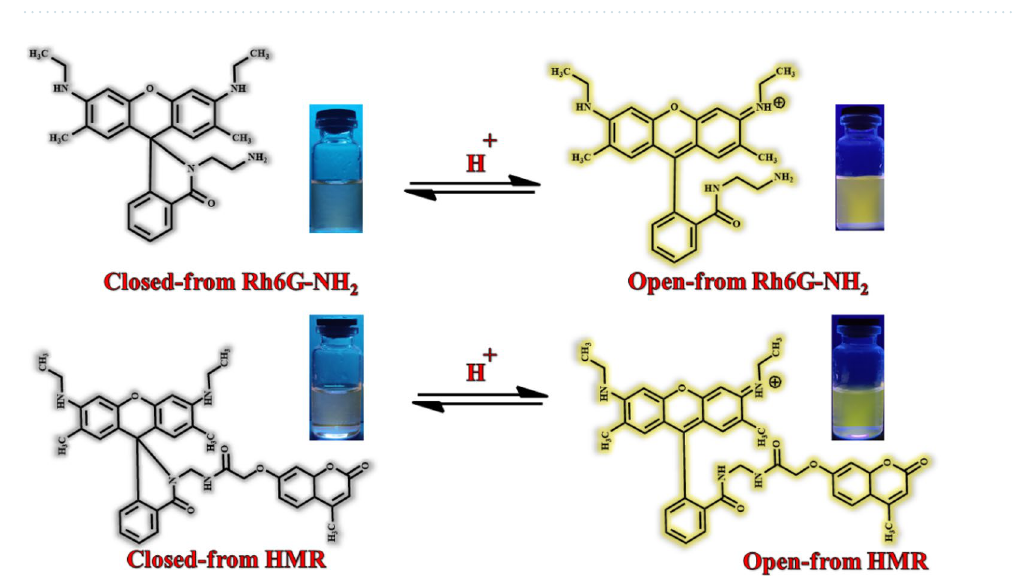
Scheme 2. Mechanism of emission rhodamine6G